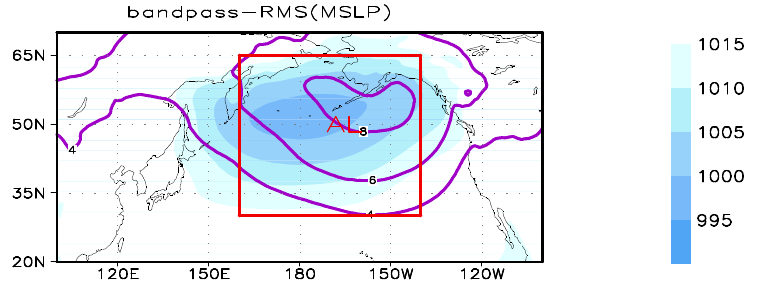
Figure 1. Climatological field of the mean sea level pressure (MSLP, shaded; hPa) and 20 to 80-day standard deviations of MSLP (contour; hPa) during winters of 1979–2014. The red box (160 ◦ E–140 ◦ W, 30–65 ◦ N) denotes the area for the definition of the Aleutian Low index on a 20 to 80-day time scale.